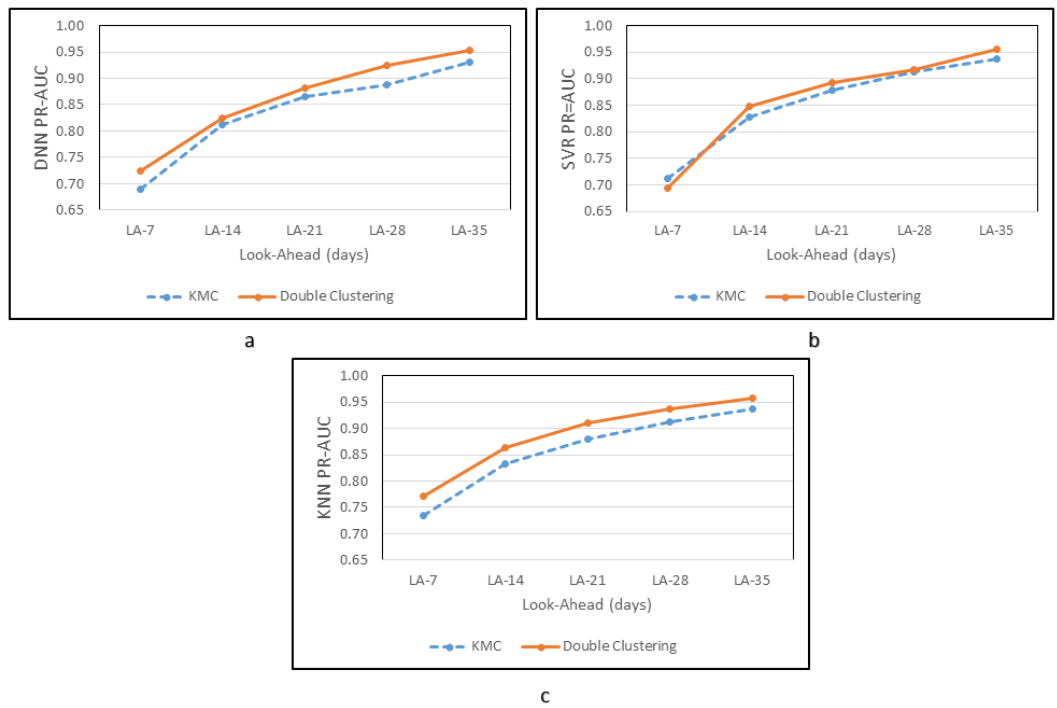
Figure 15. PR-AUC Comparison of Kmeans-C0 and Kmeans*HDBSCAN C0H0 for Machine Learning